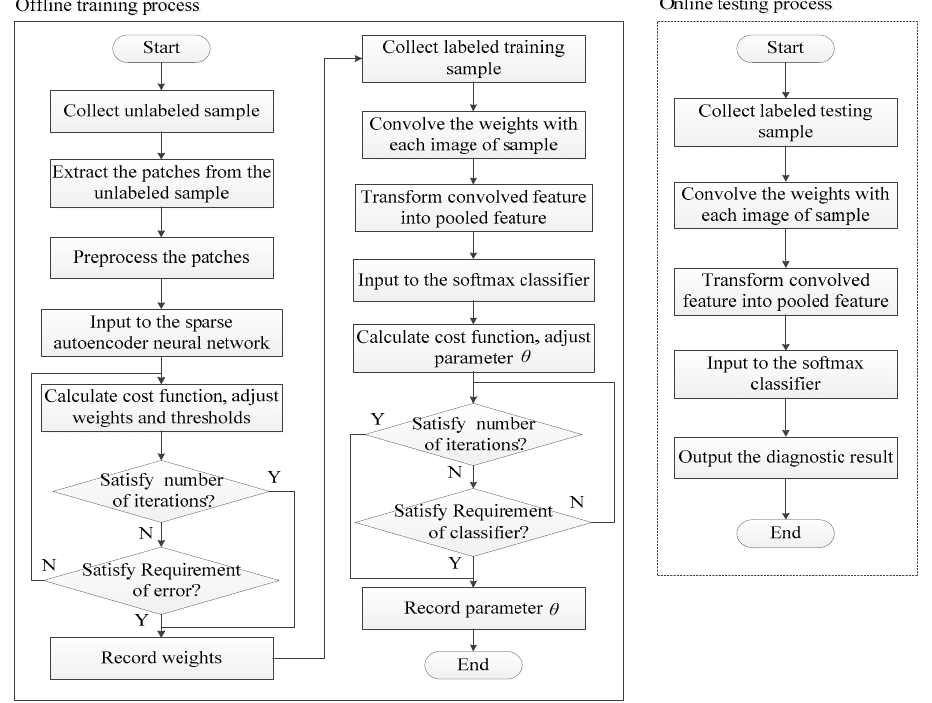
Figure 8. Training and testing flow chart. Table 4. The parameters of mentioned methods.